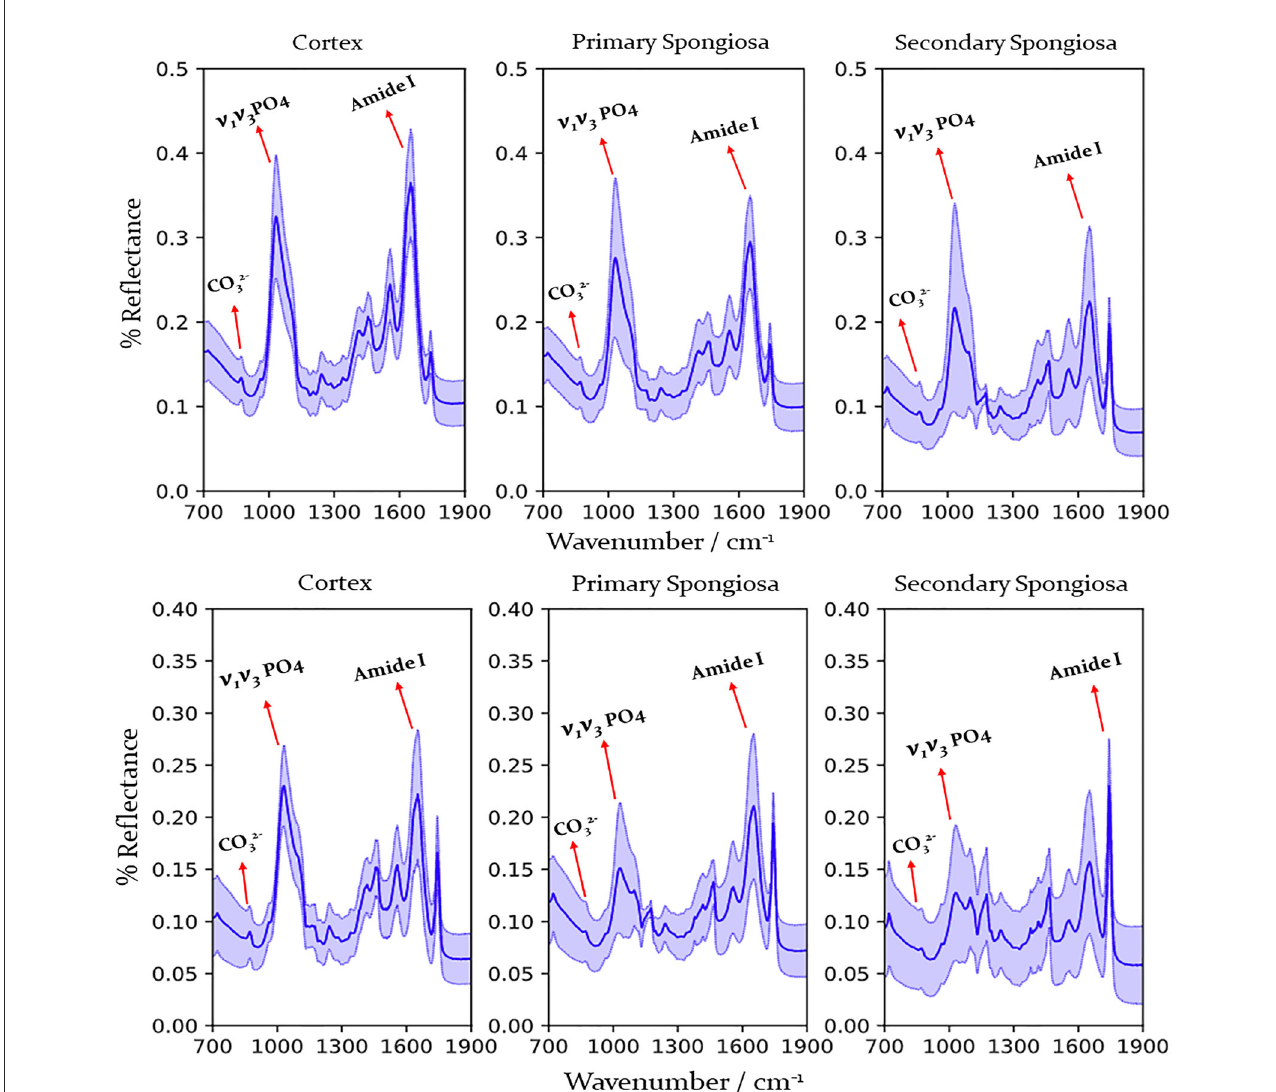
FIGURE3 FTIR spectra obtained from the humerus from cows with humeral fracture (upper graph) and control cows (no fractures) (lower graph) by location (cortex, primary, and secondary spongiosa). Labels indicate peaks used for calculation of mineral/matrix and carbonate/phosphate ratio. Dark line indicates mean, pale blue line 95% confidence interval. PO 3 − 4 , phosphate; CO 2 3 ,